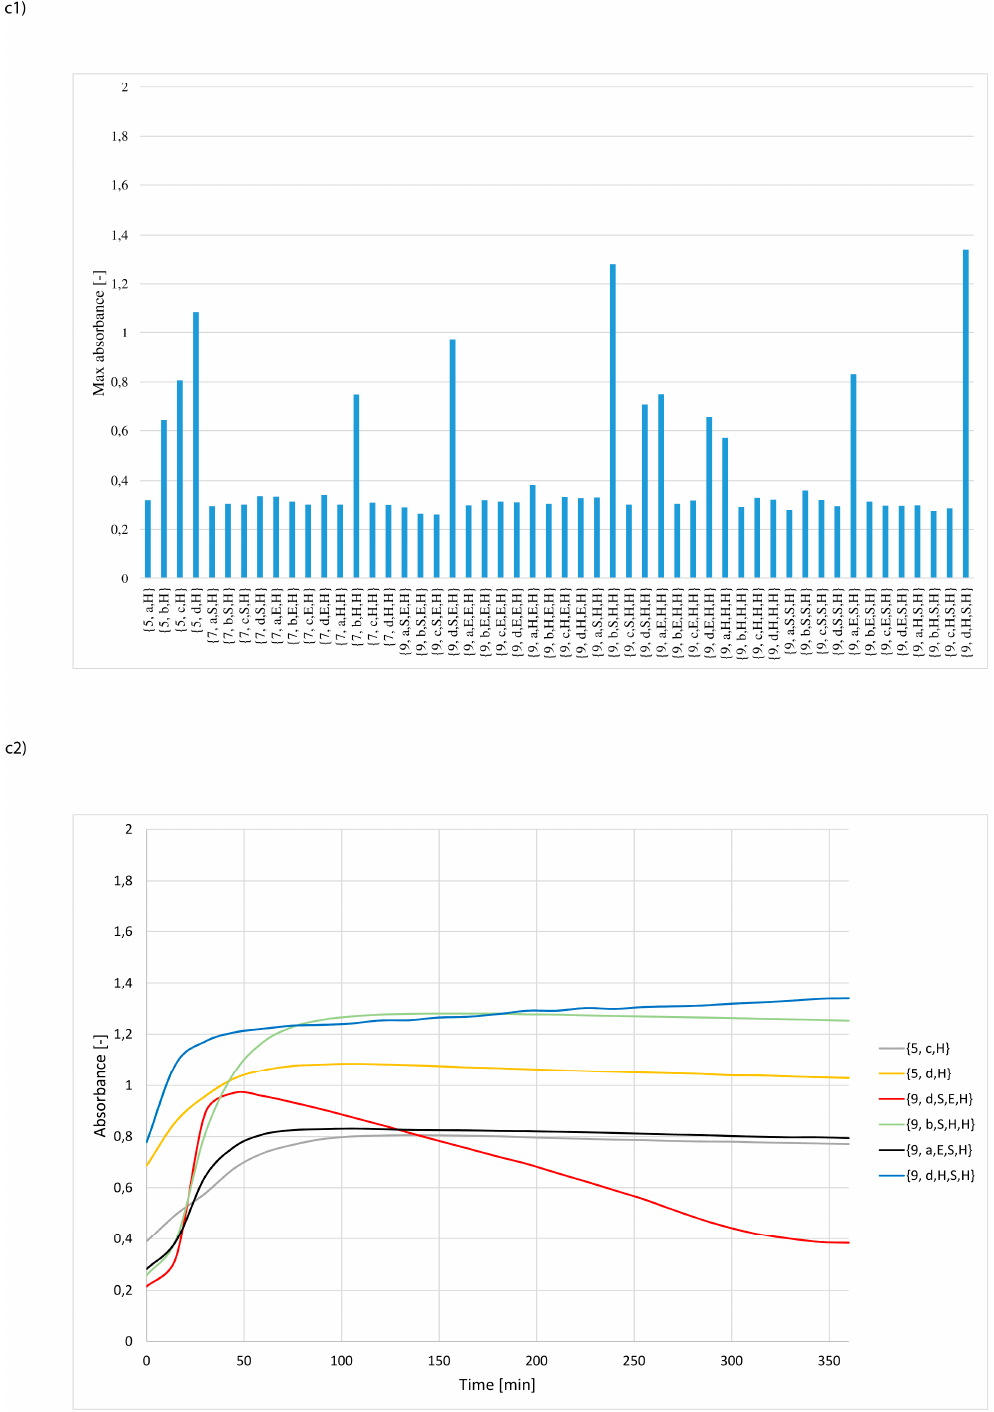
Figure 8. Selection of the most active synzymes (maximum absorbance assay) (upper panel 1) and measurement of Z-Leu-NA hydrolysis in a solution at pH = 8.5 using the selected the most active synzymes (lower panel 2) with Zn 2+ ions docked in the catalytic pocket: ( a ) sub-library of synzymes with serine reside at C-terminal positions, ( b ) sub-library of synzymes with glutamic acid reside at C-terminal positions, ( c ) sub-library of synzymes with histidine reside at C-terminal positions. The most catalytically active synzymes, affording absorbance exceeding 0.8, included: four structures containing only one amino acid residue in the active centre { 5 c,S }, { 5 b,E }, { 5 d,H }